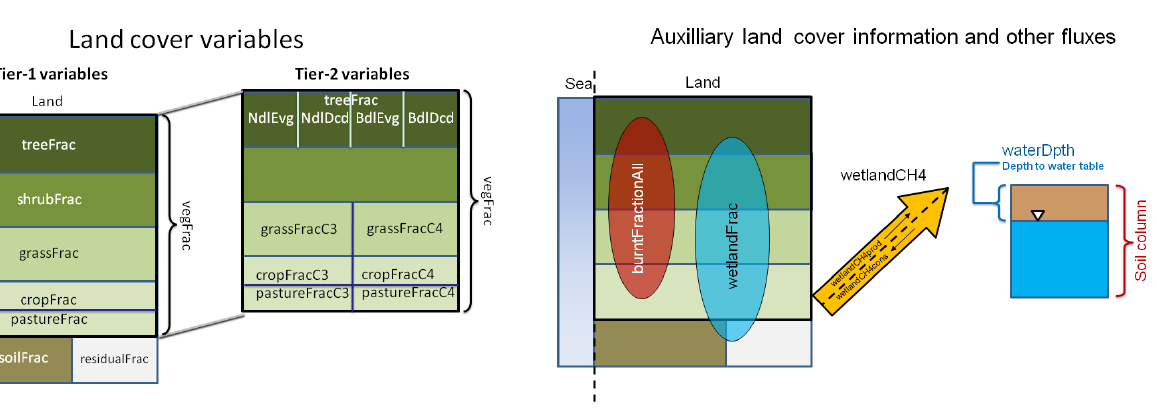
Figure 11. Requested land cover variables. Sea fraction is assume to be fixed, so must be reported under “climatology”. Fractions must sum to 1 for every grid cell (including the sea fraction). Fractions are per grid cell, not per land area.